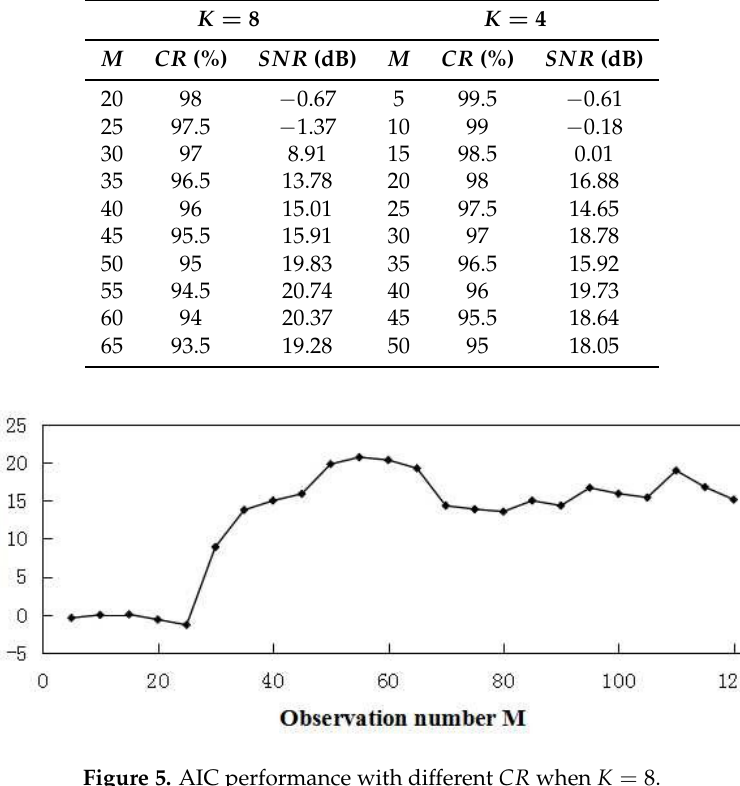
Figure 5. AIC performance with different CR when K =